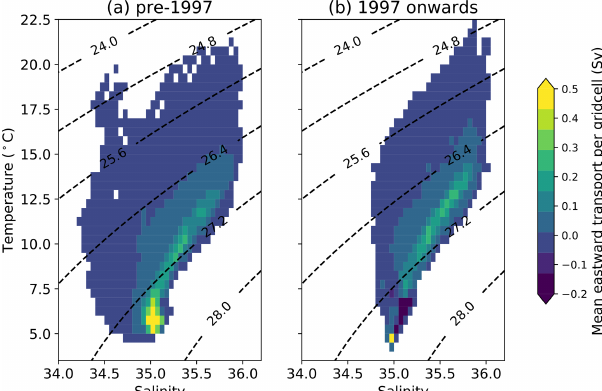
Figure 7. GODAS temperature–salinity binned eastward transport at 30 ◦ W between 45.2 and 60.2 ◦ N in the upper 1000m for (a) pre- 1997 and (b) 1997 onwards. Dashed lines are isopycnals. The sum of the grid cells in (a) is 17.2Sv and (b)